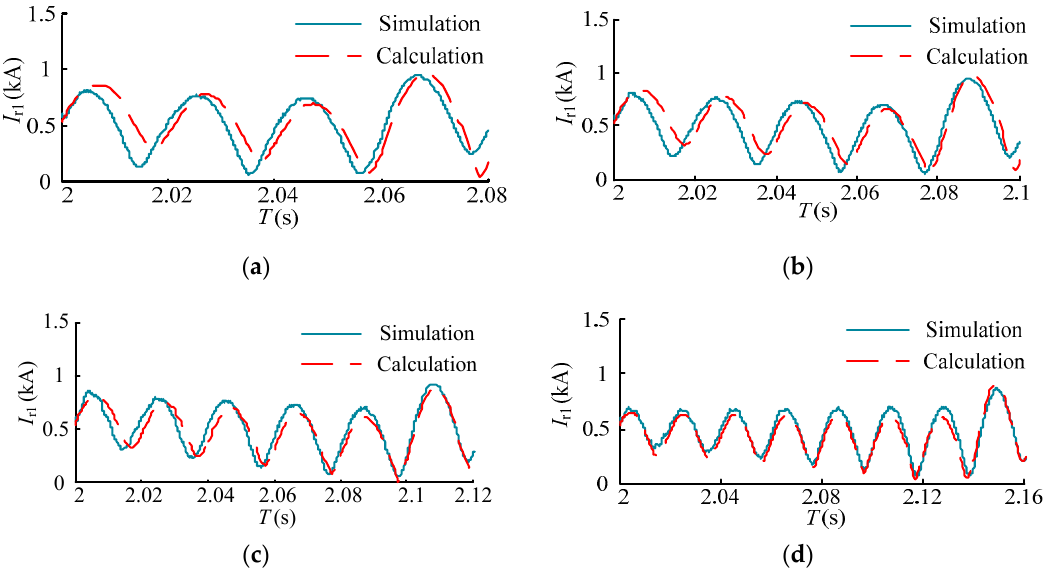
Figure 13. Comparison between calculation and simulation. ( a ) Voltage sag of 0.5; ( b ) voltage sag of